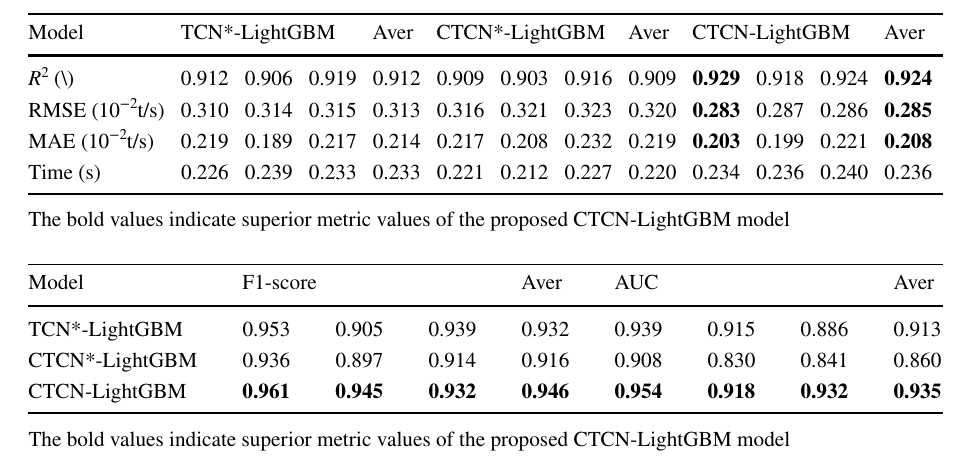
Table 9 Prediction results of each model for the truck speed adjustment modelModel The bold values indicate superior metric values of the proposed CTCN-LightGBM Table 10 Classification results modelModel of each model for the truck speed adjustment